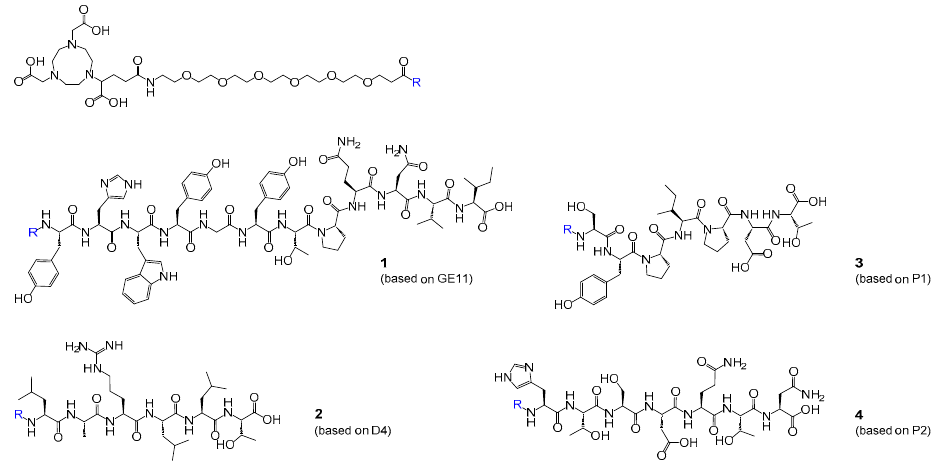
Figure 2. Structures of the N -terminally PEG 5 -NODA-GA-modified labeling precursors based on the peptides GE11 ( 1 ), D4 ( 2 ), P1 ( 3 ) and P2 ( 4 ).